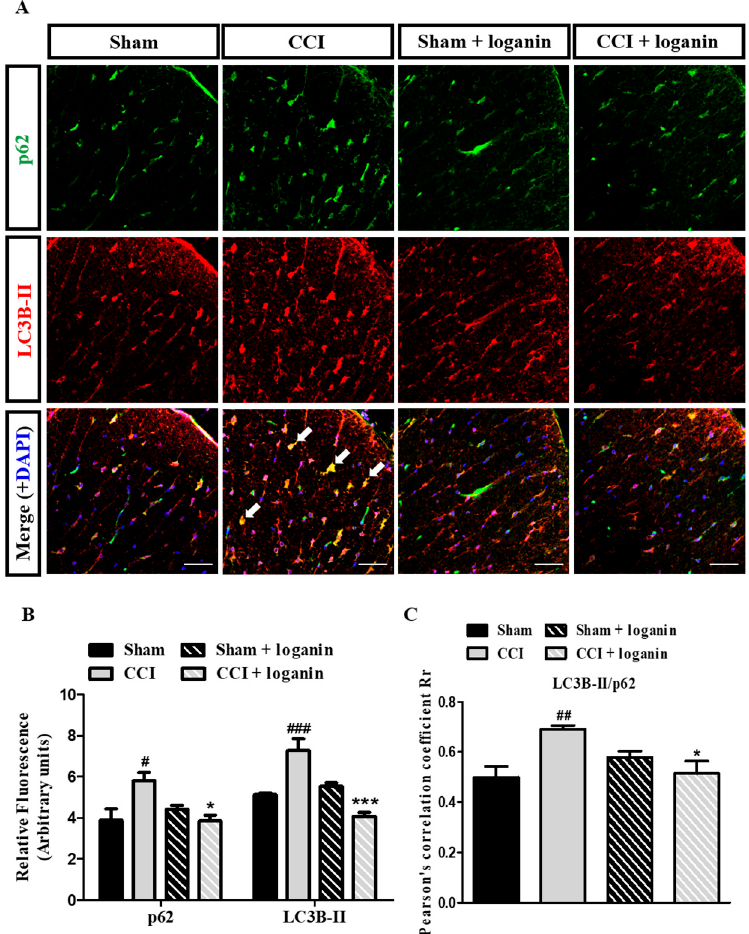
Figure 3. Double immunofluorescent staining for LC3B-II (autophagosome marker) and p62 (au- tophagic flux marker) in the spinal cord on day 7 after chronic constriction injury (CCI). ( A ) Repre- sentative images of IHC staining for p62 (green) and LC3B-II (red) in the spinal cord. Arrows point to representative LC3B-II and p62 colocalization. The scale bar is 50 μ m. ( B ) Quantification of p62, LC3B-II signals in ( A ). ( C ) Pearson’s correlation coefficients quantified the degree of colocalization between p62 and LC3B-II. Sham-operated rats were the subjects of the same procedure without nerve manipulation. These data represent the mean ± SE for 6 rats per group. # p < 0.05, ## p < 0.01, ### p < 0.001 compared with sham group at the corresponding time points; * p < 0.05, *** p < 0.001 compared with CCI group.